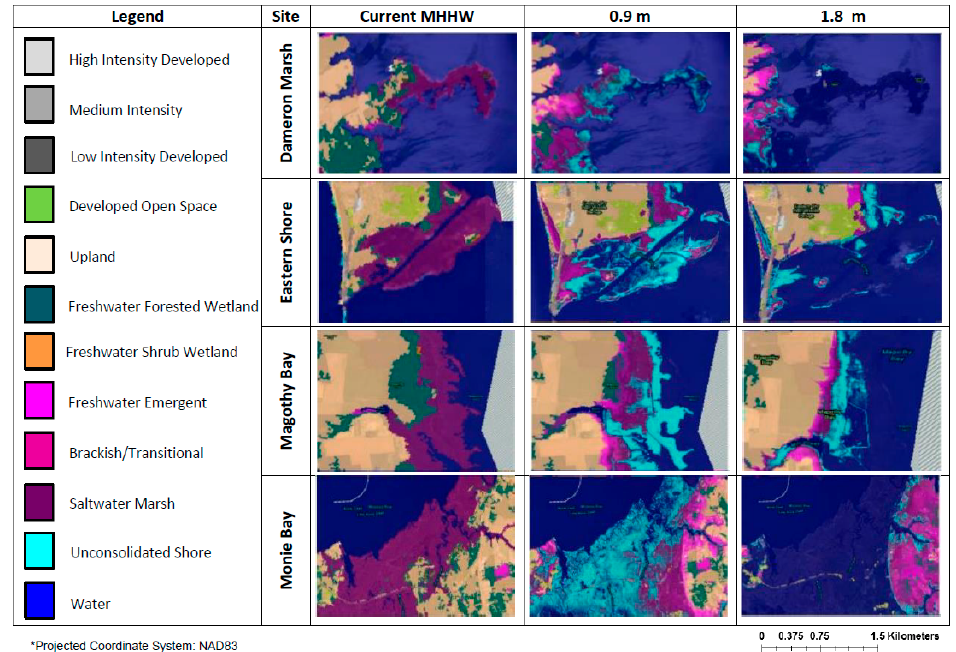
Figure 2. Land cover changes in each study area due to the different SLR–marsh migration scenarios.